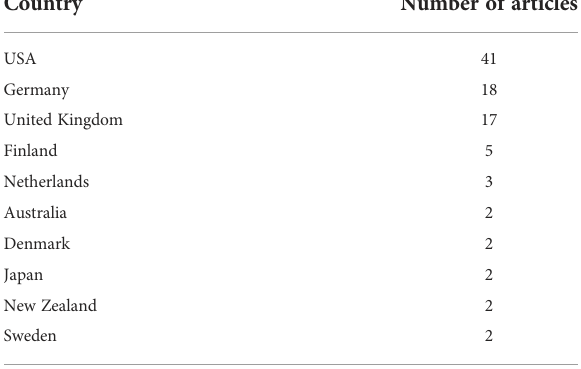
TABLE 3 Top 10 list of geographic origin. Country